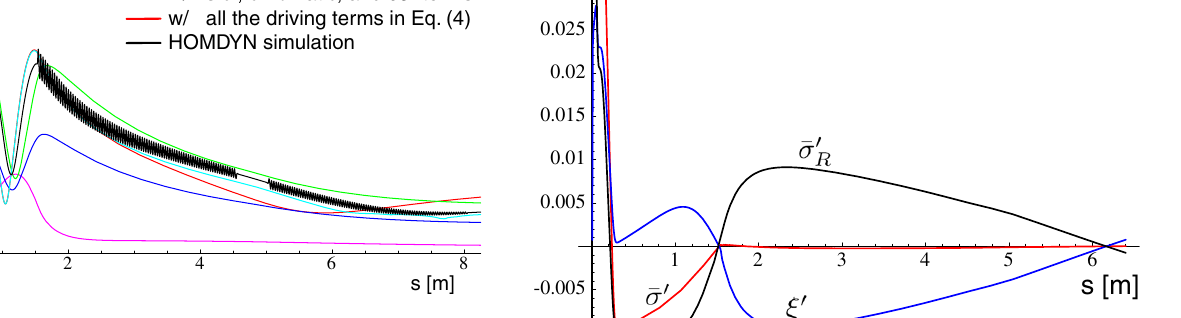
FIG. 4. (Color) Effects of various driving terms on the emit- tance. The black curve is from HOMDYN . The magenta, blue, green, cyan, and red curves include, respectively, from 0 in- creasingly up to all 4 driving terms in Eq. (4) in the order that they appear in the